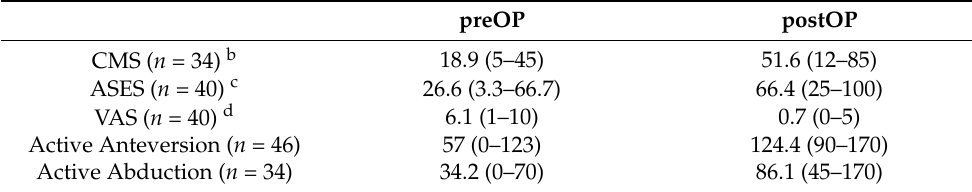
Table 3. Weighted means of the pooled data a